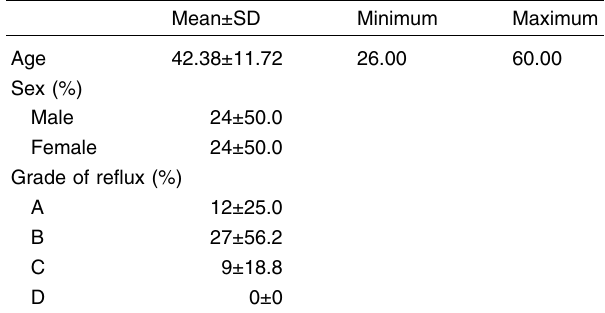
LA classification of reflux esophagitis. LA, Los